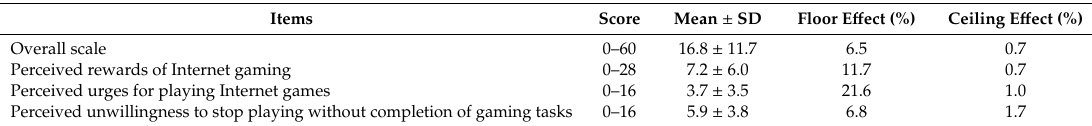
Table 4. Descriptive statistics for the subscales of the Chinese version of revised Internet Gaming Cognition Scale.